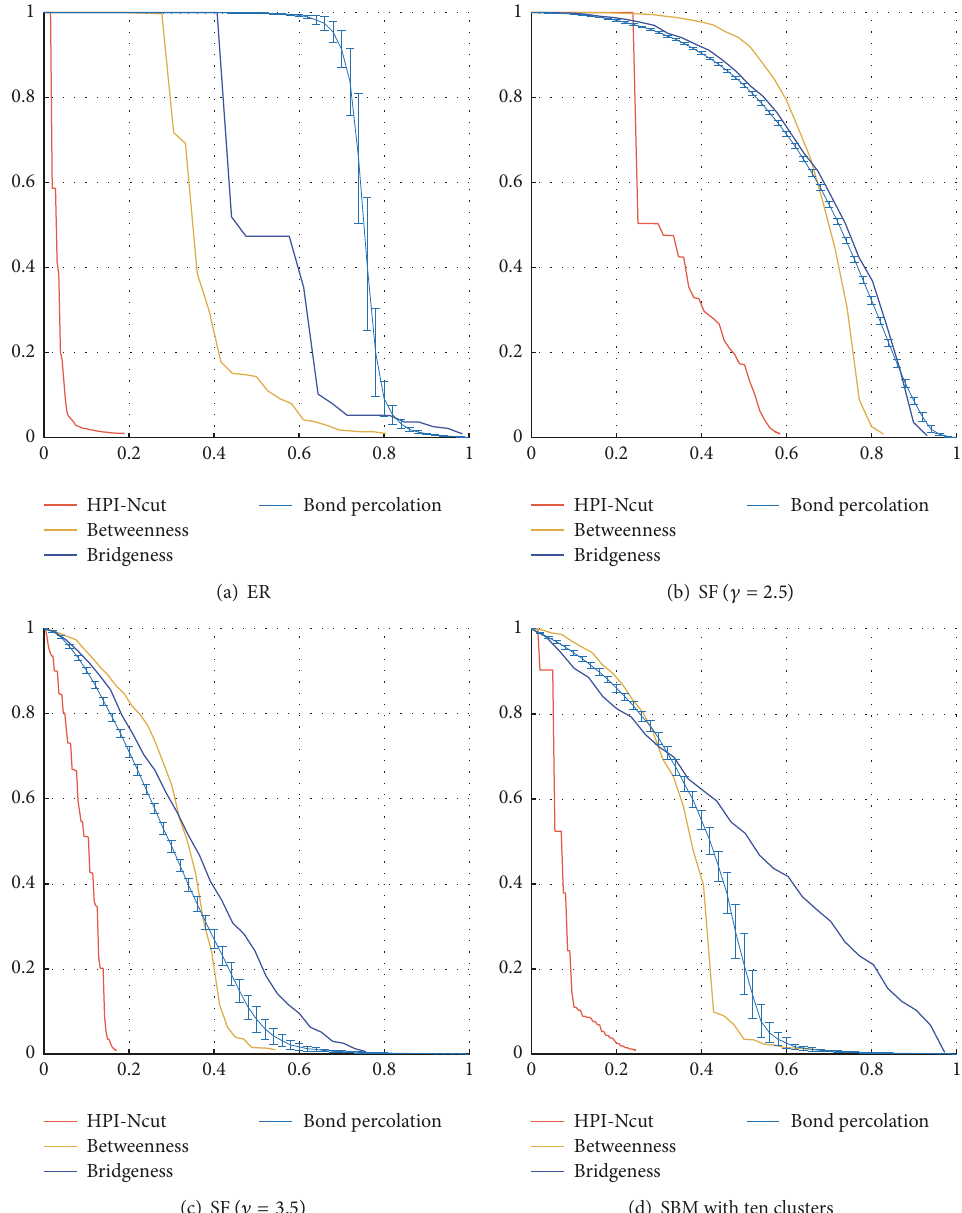
Figure 4: The size of the GCC of the networks versus link removing proportion, comparing with existed link removal-based methods on artificial networks. The results of the bond percolation are obtained after 100 independent